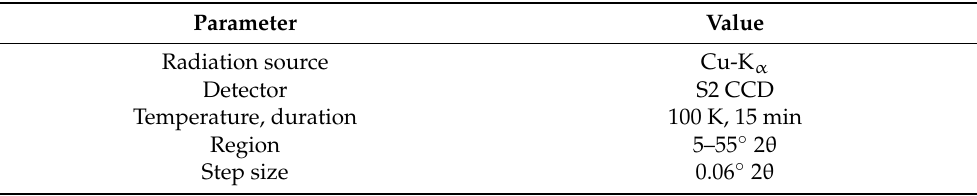
Table A2. Measurement conditions on the STADI P X-ray powder diffractometer for the radio- graphic examination of aluminosilicate powder samples for the identification and quantification of crystalline